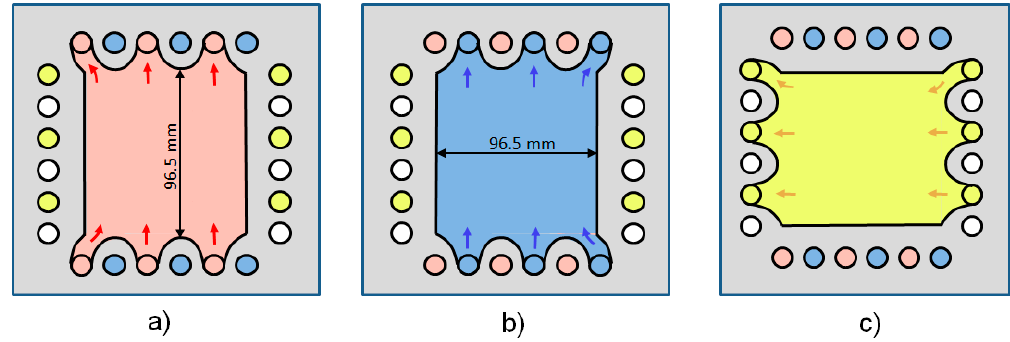
Figure 3. Subsequent cell frames for one repeating cell unit: ( a ) for up-flow of HCl, ( b ) for up-flow of NaOH and ( c ) for cross-flow of the NaCl solution.